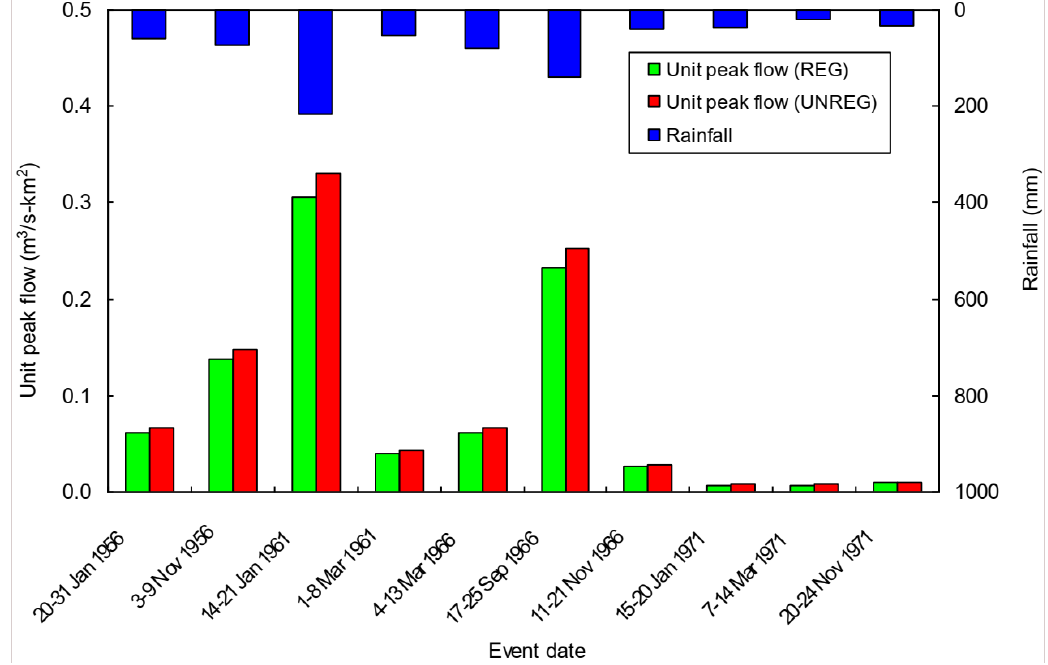
Figure 7. Rainfall height and peak flow simulated by the HEC-HMS model in unregulated (UNREG) and regulated (REG) sub-catchments (Calabria, Southern Italy)—events are not reported on the time scale.